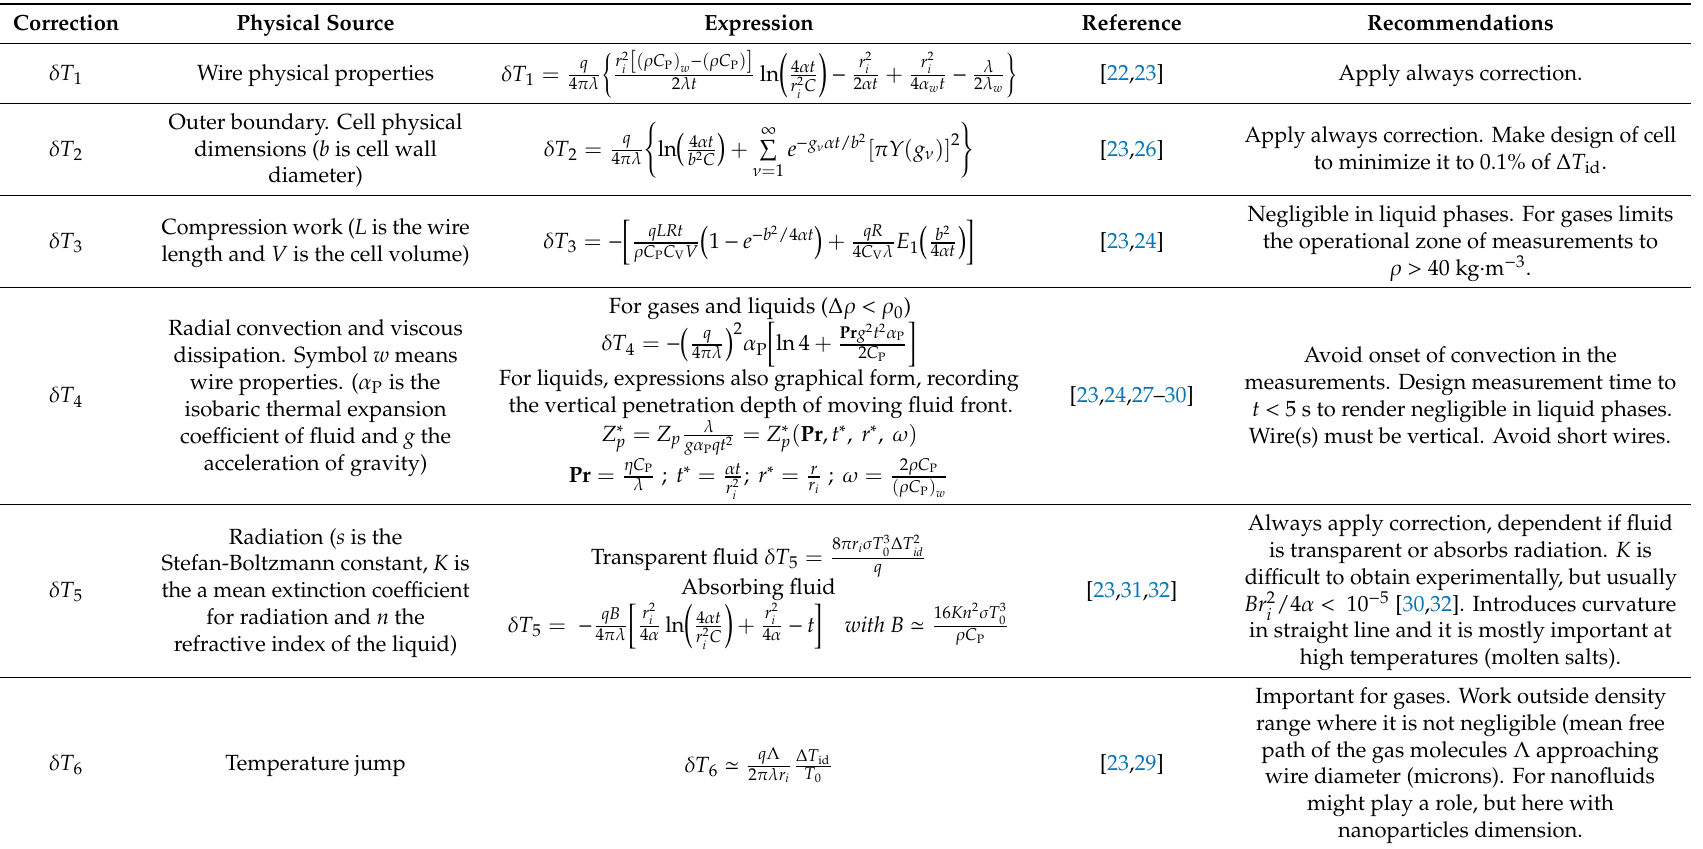
Table 2. Departures from ideal model of transient hot-wire